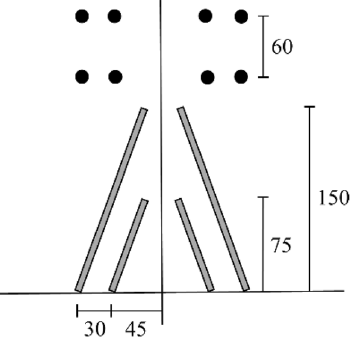
Figure 3. Compound wedge-shaped cutting hole layout scheme (cm).